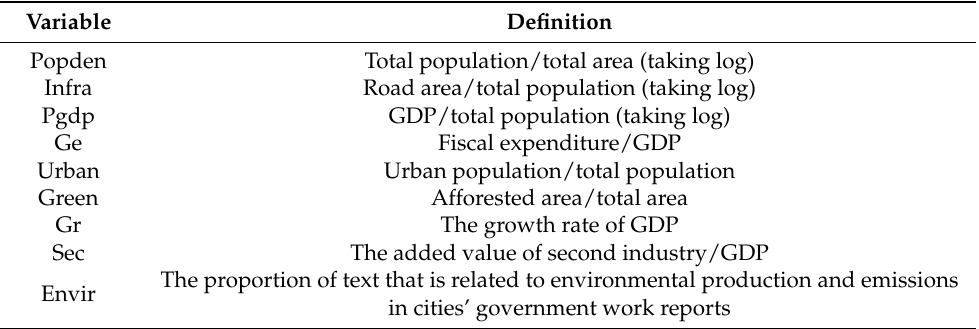
Table A1. The definition of control